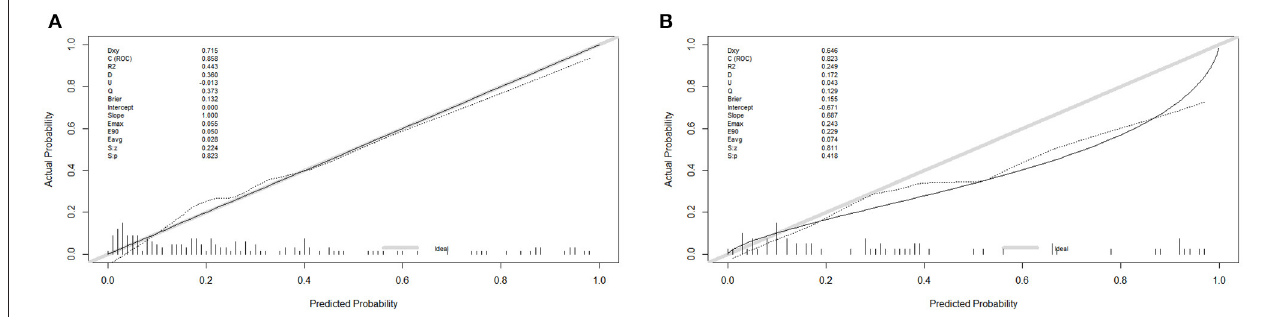
FIGURE 5 | The calibration plot in the training and validation cohort. (A) The calibration plot in the training cohort. (B) The calibration plot in the training cohort.